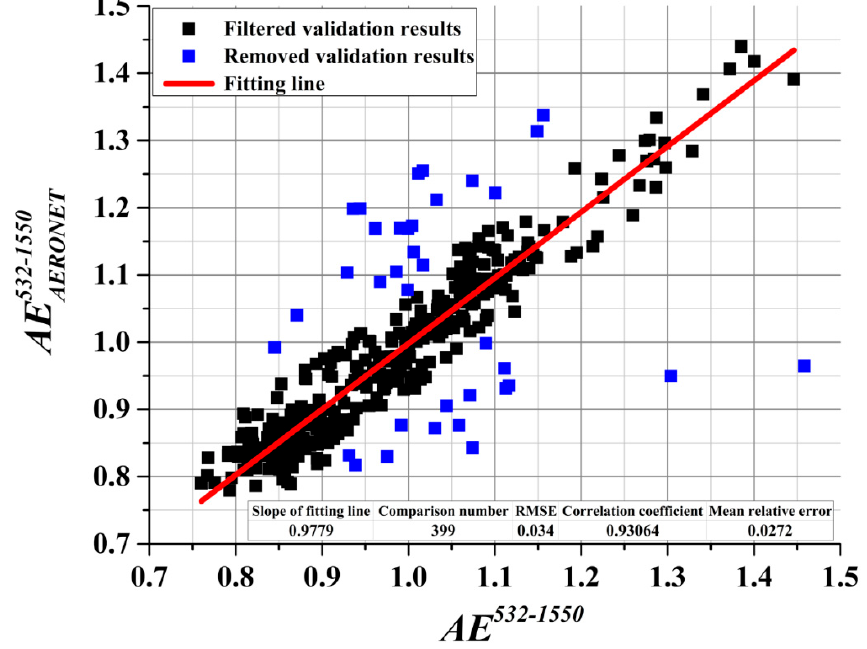
Figure 4. Validation results of all joint measurements for the retrieval method with Mie-scattering lidar. The black dots are the filtered relationship of AE 532-1550 and AE 532-1550 removed ones, the red line is obtained by linear fitting of verification results, the embedded table shows the detailed evaluation indicators of this retrieval method.